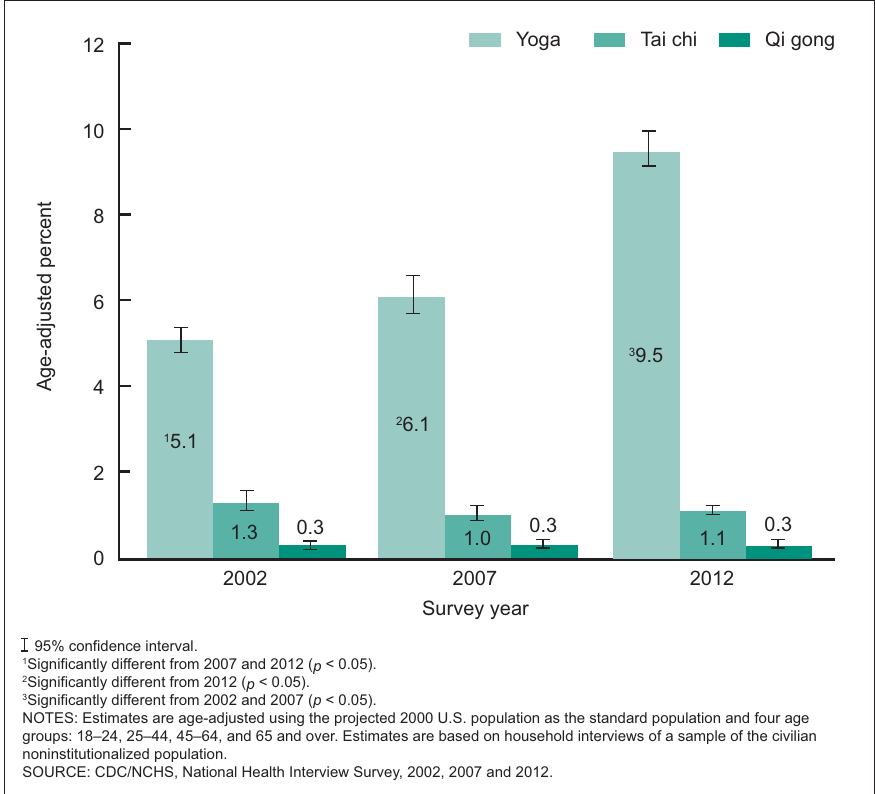
Figure 1. Use of yoga, tai chi, and qi gong among adults in the past 12 months: United States, 2002, 2007, and 2012